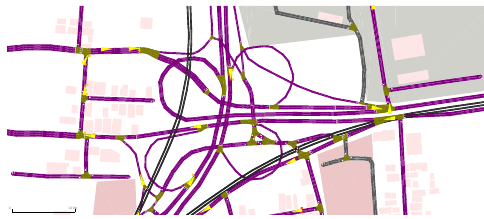
Figure 2. SUMO road infrastructure map of Kathipara Junction in Chennai, India.